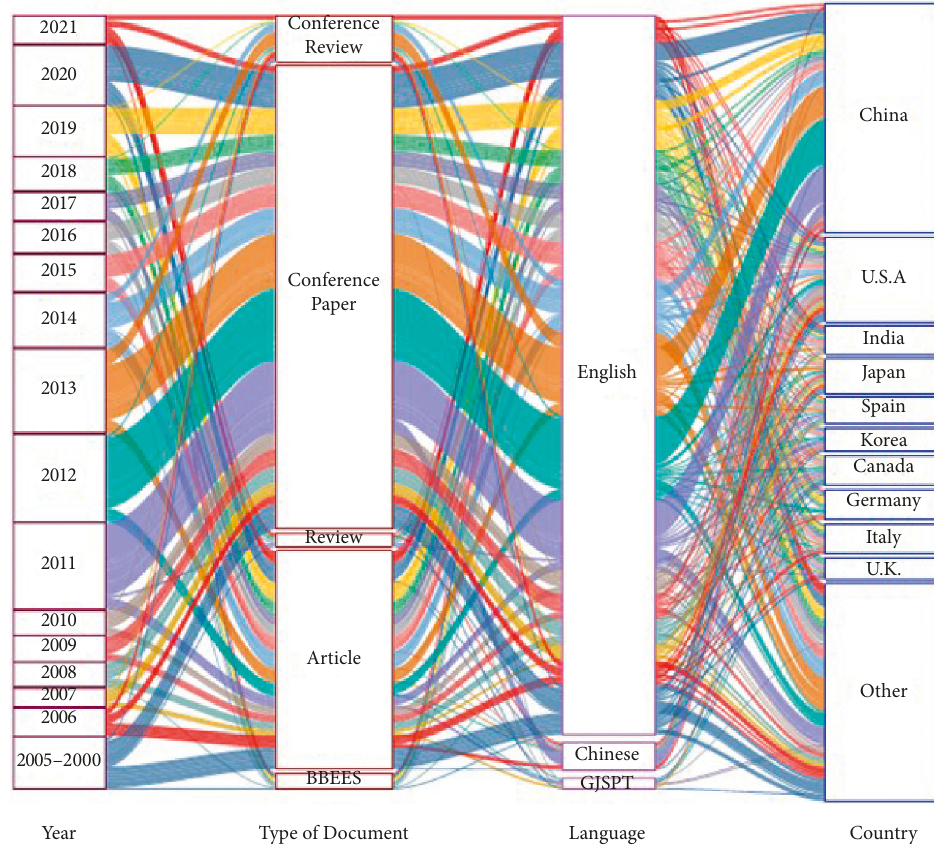
Figure 9: Publication overview with language and country for the period from 2001 to 2021.